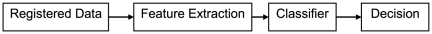
Operational stages of a pattern recognition system.The flow chart of recognition processes can be illustrated using four simple stages: registration of data, extraction of the target's features, classification, and decision making. The feature extracted from the registered data is fed into a classifier, which can be based on Cross-plot, artificial neural network or Bayesian network, for target object classification. The accuracy of identification is dependent on the quality of features being extracted. Finally a decision is made based on the classified results that will lead to the identification of the interested target.